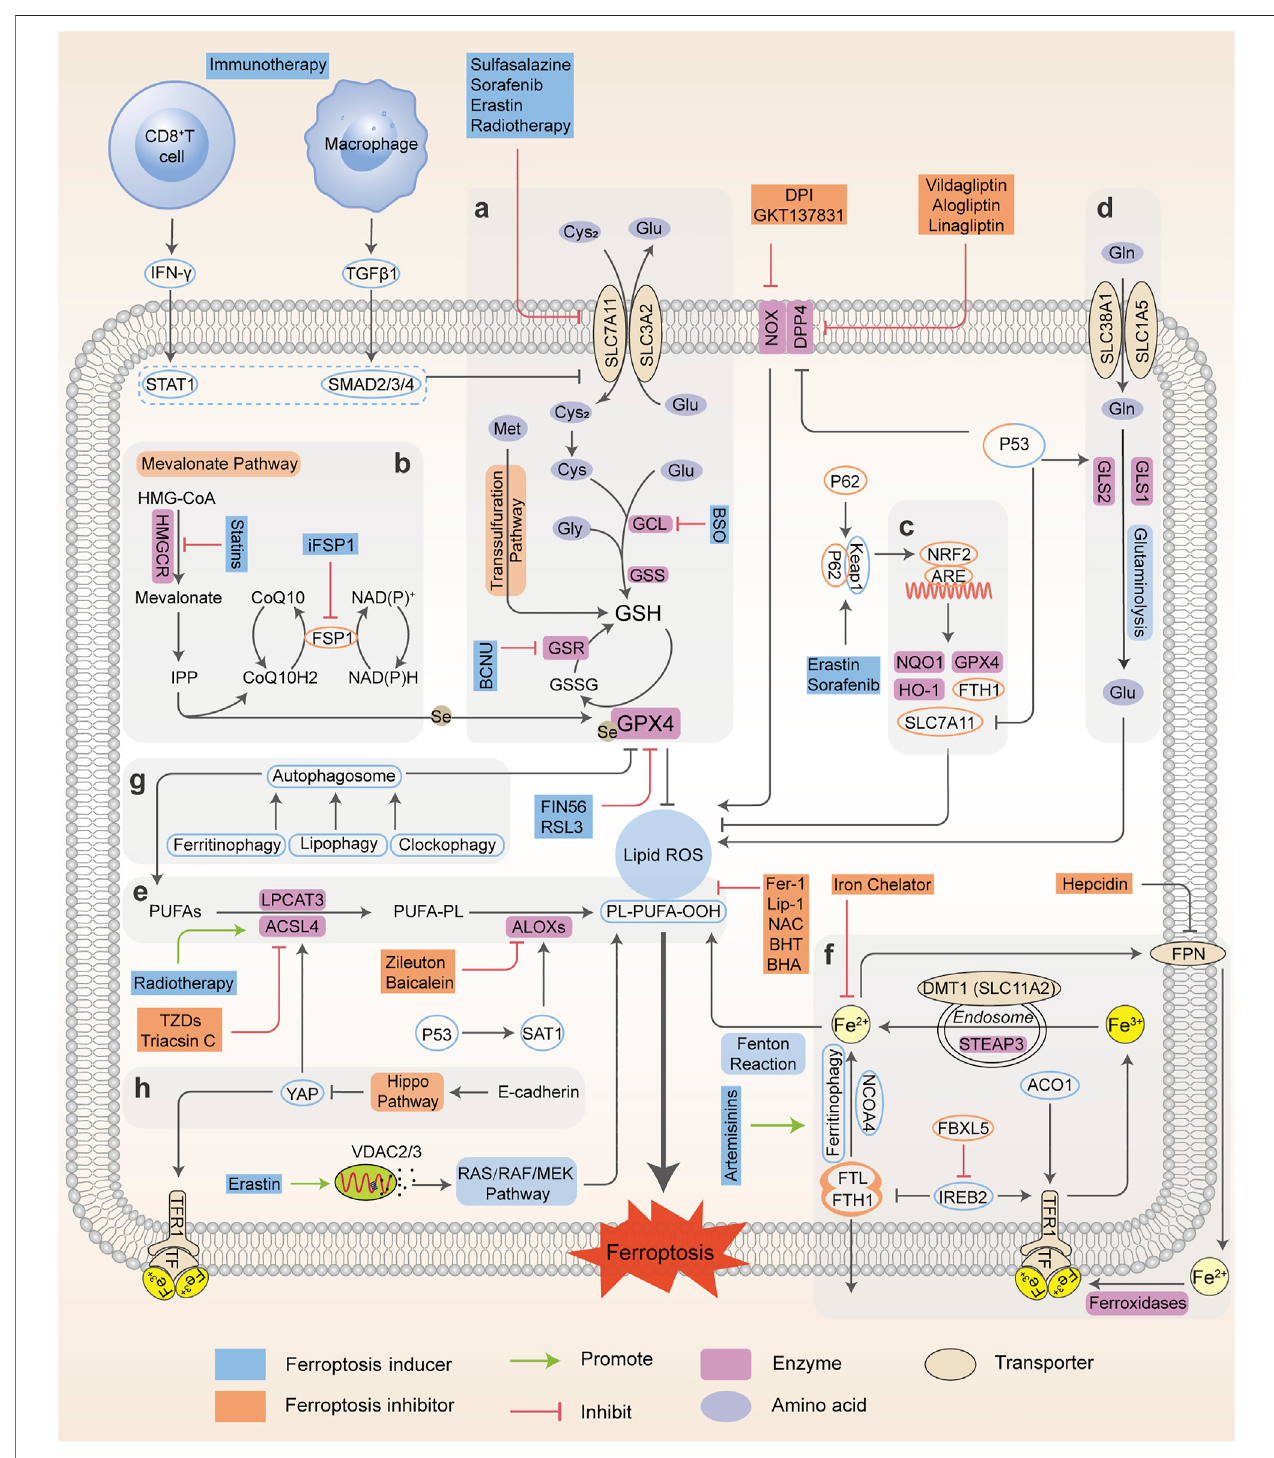
FIGURE 1 | Regulatory networks and signaling pathways associated with ferroptosis. Ferroptosis is primarily activated by iron-dependent lipid peroxidation and redox perturbation, which mainly occurs through two major pathways, the extrinsic or transporter-dependent pathway, and the intrinsic or enzyme-regulated pathway. (A) The cyst(e)ine/GSH/GPX4 antioxidative axis. (B) The mevalonate pathway (IPP/FSP1/CoQ10 system). (C) NRF2-regulated ARE defence. (D) The glutaminolysis pathway. (E) The lipid peroxidation process; (F) The absorption, export, storage and utilization of iron. (G) The autophagy cascade. (H) The EMT-related pathway. Processes favoring or counteracting ferroptotic cell death are labeled with red and green arrows, respectively (Cys 2 , cystine; Cys, cysteine; Glu, glutamate; Gly, glycine Gln, glutamine; BCNU, 1,3-bis-(2-chloroethyl)-1-nitrosourea; CoQ10H2, ubiquinol; HMG-CoA, 3-hydroxy-3-methyl glutaryl coenzyme A; GSR, glutathione-disul fi de reductase; BHA, butylated hydroxyanisole; BHT, butylated hydroxytoluene).